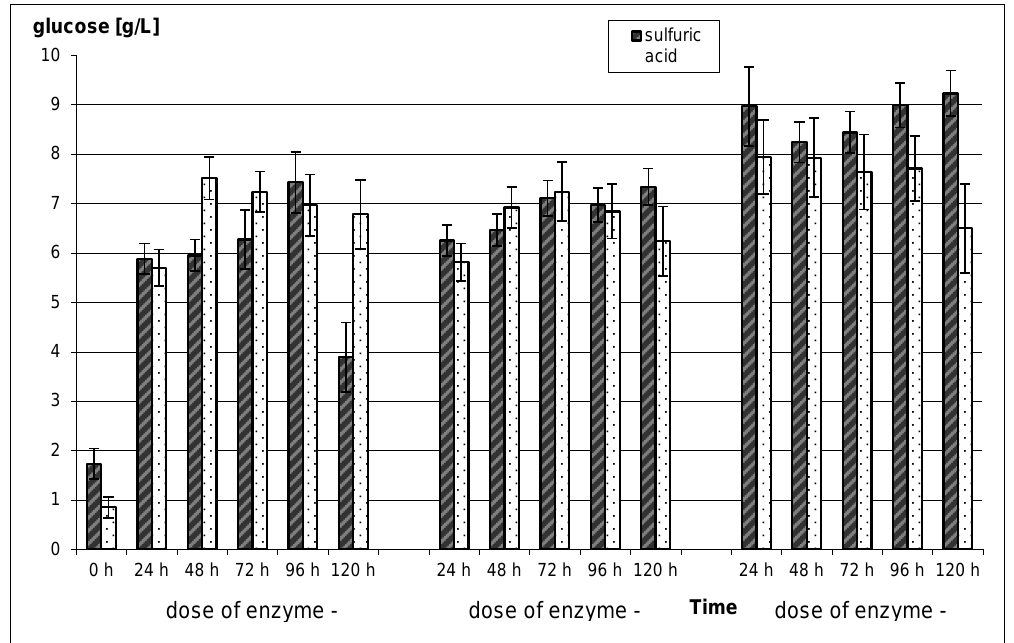
Figure 3. Enzymatic hydrolysis of pretreated rye straw using 2% sulfuric acid and water at 121 °C and 1 h. Control sample—Rye straw With water and sulfuric acid at 121 °C and 1 h—Not subjected to enzymatic treatment.